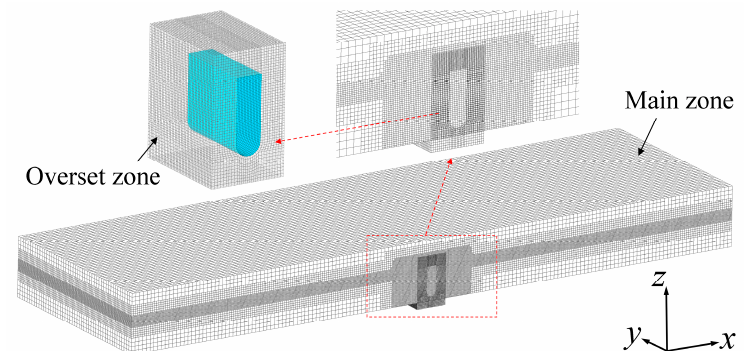
Figure 11. The selected mesh model (medium size) of the NWT in CFD, including a main zone and a